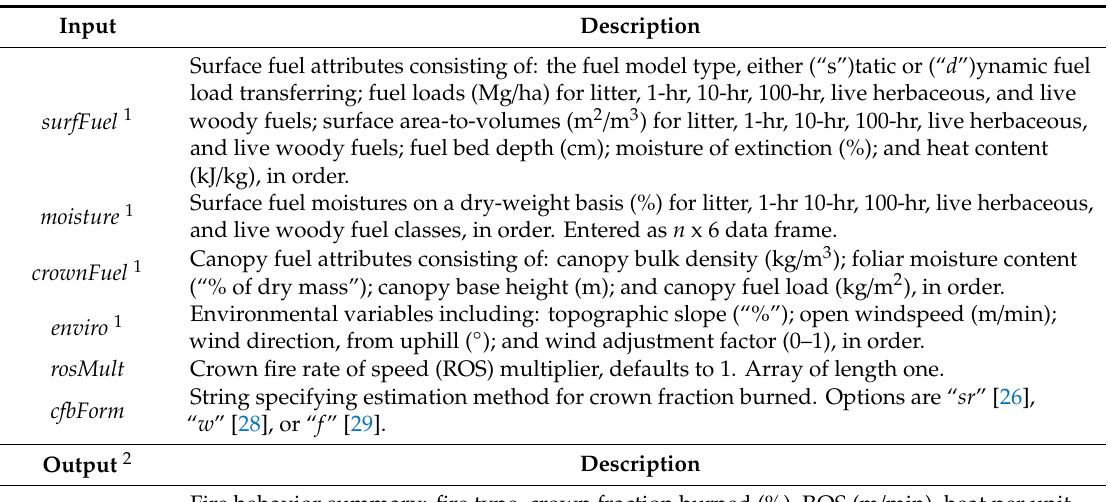
Table 1. Inputs and outputs for the rothermel() function.